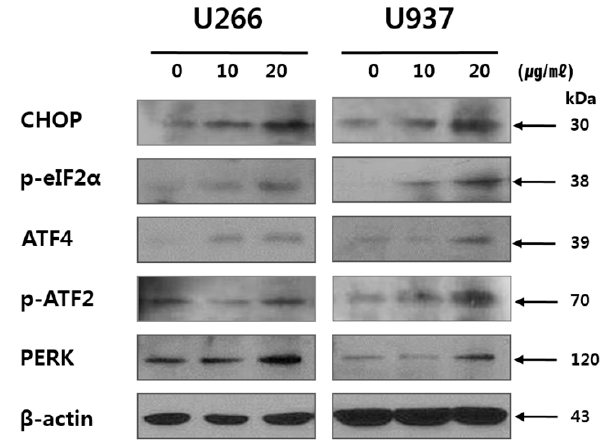
Figure 4. Effect of SSD on endoplasmic reticulum (ER) stress-related protein in U266 and U937 cells. Cells were treated with SSD (10 or 20 µg/mL) for 24 h. The lysates were subjected to Western blot analysis for CHOP, p -elF2 α , ATF4, p -ATF2, PERK, and β -actin. Results show a representative of three independent experiments.